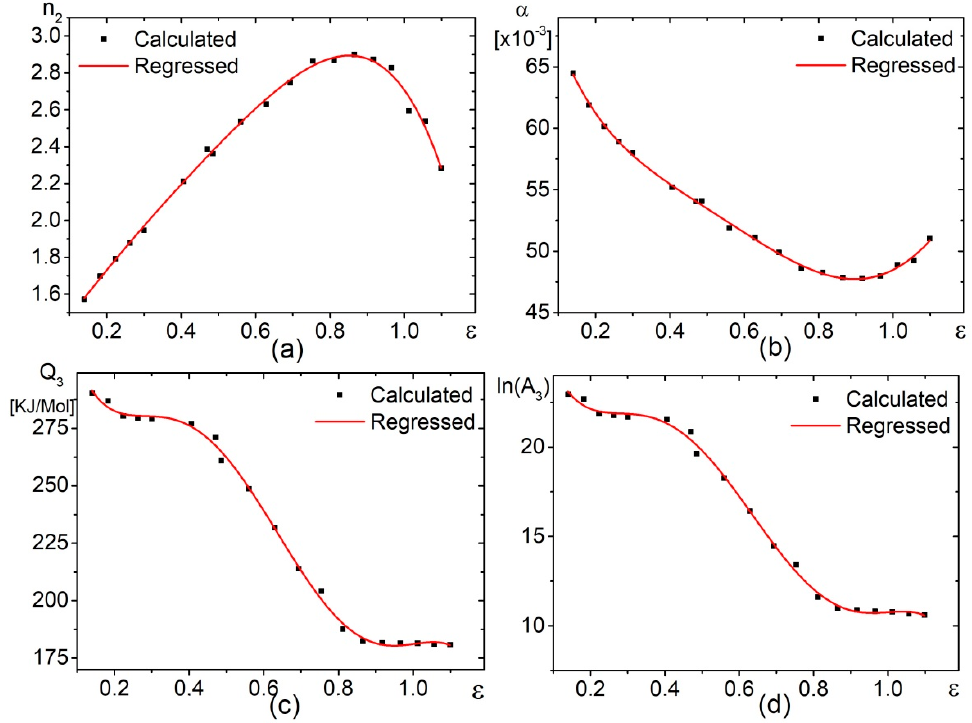
Figure 3 . The dependence of n 2 ( a ) , α ( b ), (cid:1843) (cid:2871) ( c ) and ln( A 3 ) ( d ) constants vs true strain ( ε ). Figure 3. The dependence of n 2 ( a ), α ( b ), Q 3 ( c ) and ln( A 3 ) ( d ) constants vs true strain ( ε